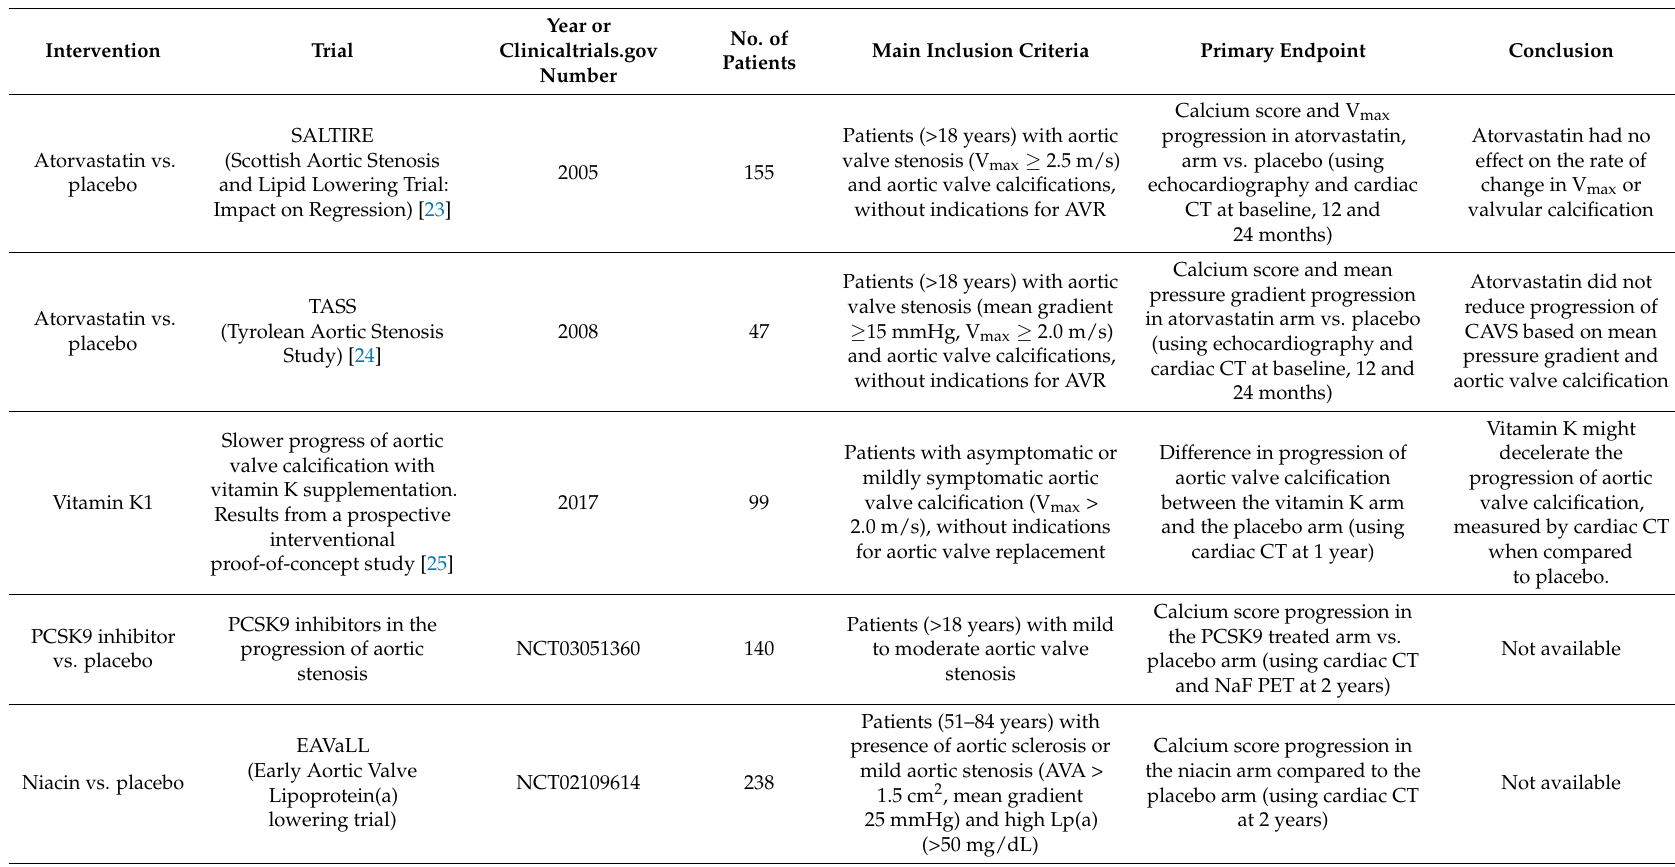
Table 1. Overview of randomized controlled trials, performed with various pharmacological interventions, to halt progression of calcification in aortic valve stenosis.